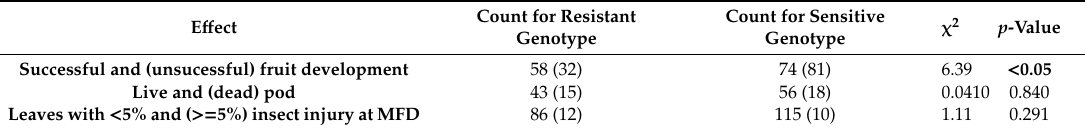
Table 2. E ff ect of ambient ozone level on resistant and sensitive genotypes of Phaseolus vulgaris . MFD is maximum flowering day. The Chi-square value and the significance level are shown. Bolded p-value means statistically significance. Count for Resistant Count for Sensitive χ 2 p E ff ect Genotype Genotype